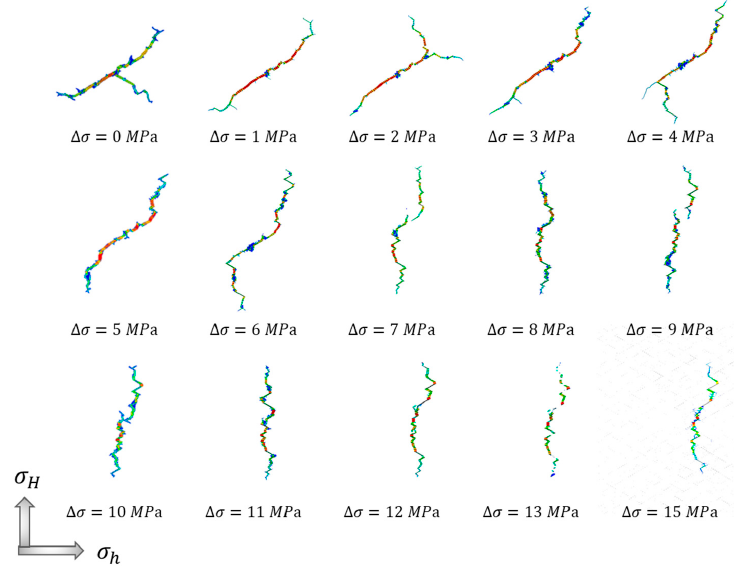
Figure 8. The extracted morphology of hydraulic fractures under different in situ stress differences.